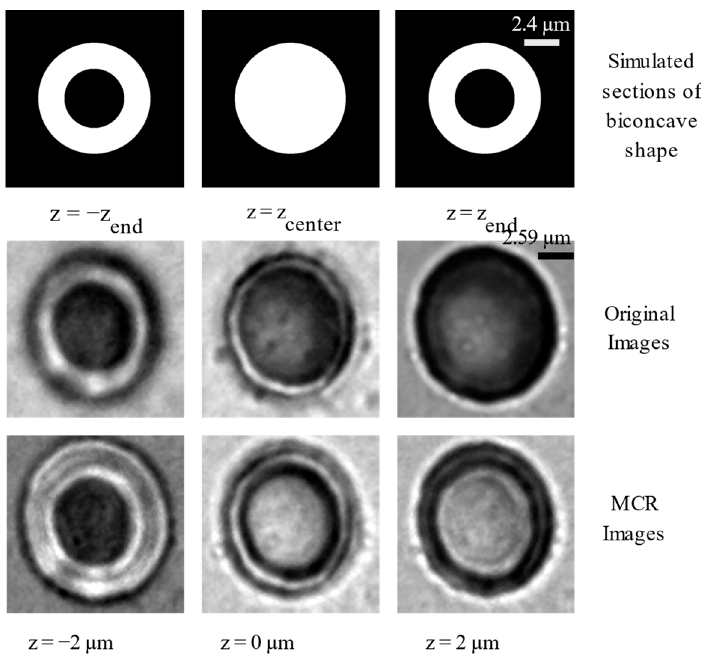
Figure 4. Images of simulated biconcave sections: original and MCR images.